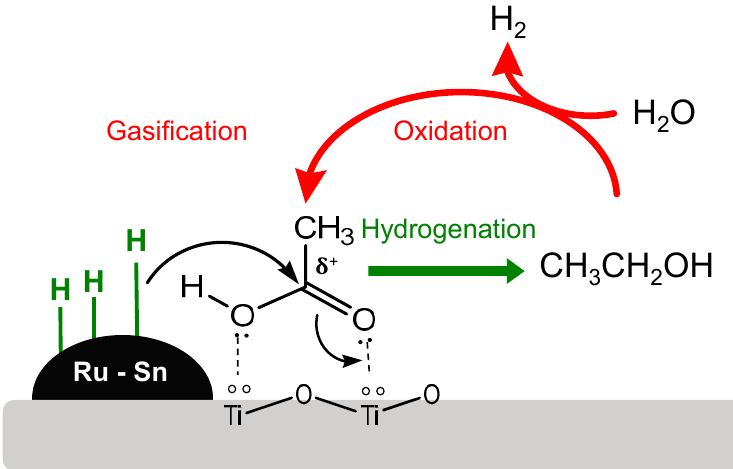
Figure 6. Proposed mechanism illustrating oxidation of the product ethanol and gasification competing with hydrogenation of aqueous acetic acid to ethanol over Ru-Sn / TiO 2 catalyst in the flow type